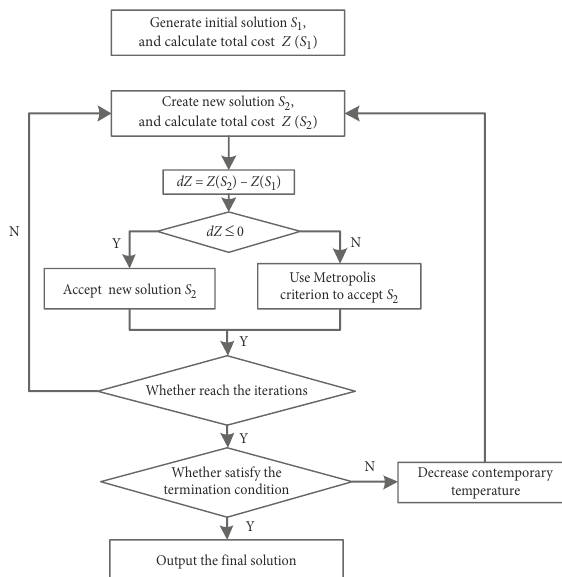
Figure 1. Flow chart of simulated annealing algorithm